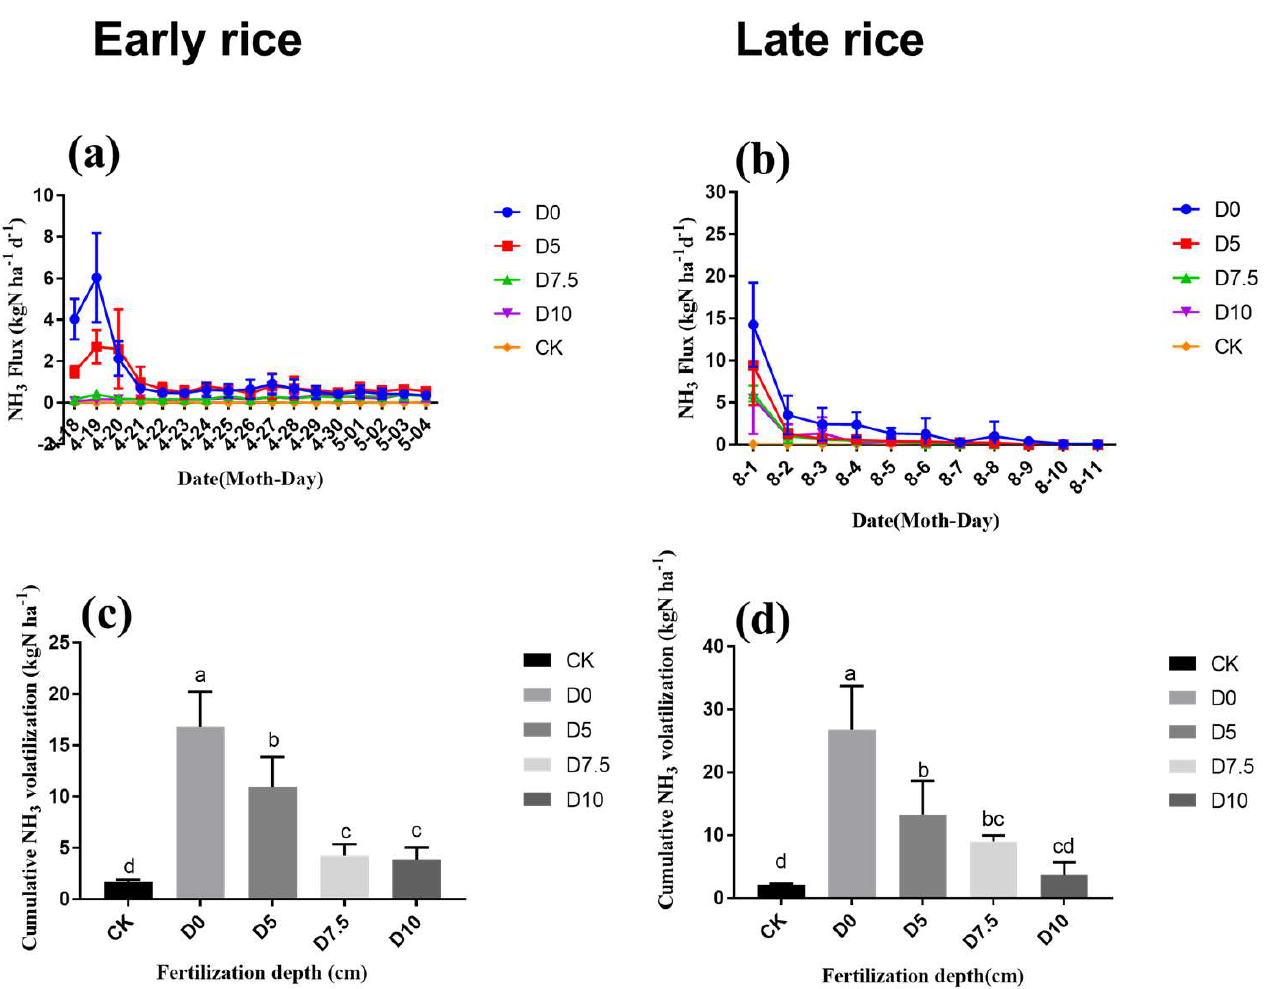
Figure 6. NH 3 flux and accumulation of early rice and late rice under different fertilization depths. ( a ): Dynamic change of NH 3 flux in early rice; ( b ): Dynamic change of NH 3 flux in late rice; ( c ): Accumulation of NH 3 volatilization in early rice; ( d ): Accumulation of NH 3 volatilization in late rice. CK: no fertilizer; D0: surface spreading; D5: 5 cm side−deep fertilization; D7.5: 7.5 cm side−deep fertilization; D10: 10 cm side−deep fertilization. Different lowercase letters in the figure indicate sig- nificant difference among treatments at P = 0.05 (LSD).